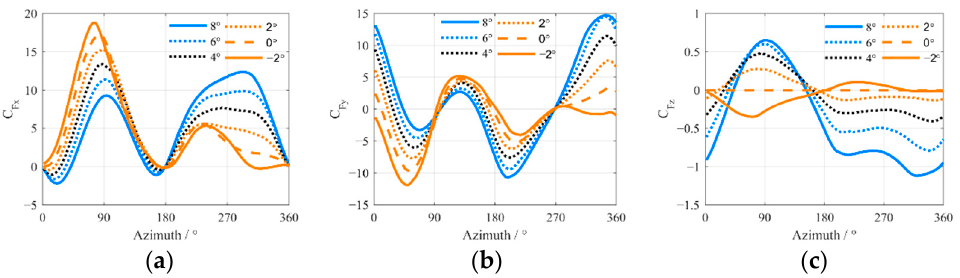
Figure 7. Instantaneous aerodynamic forces of a blade with different fold angles: ( a ) C Fx ; ( b ) C Fy and ( c ) C Fz